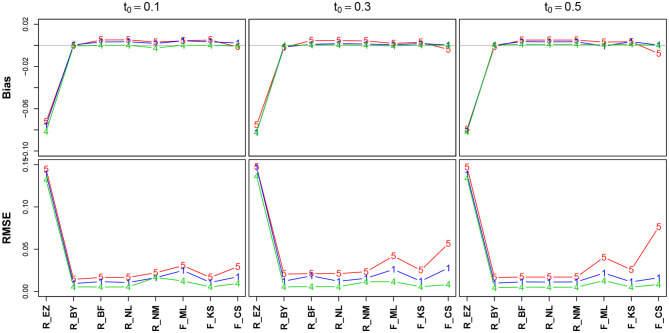
Bias (upper row) and RMSE (lower row) of the encoding and response time TER. red line/symbol “5”: 50 trials; blue line/symbol “1”: 100 trials; green line/symbol “4”: 400 trials; for abbreviations see Figure 3.